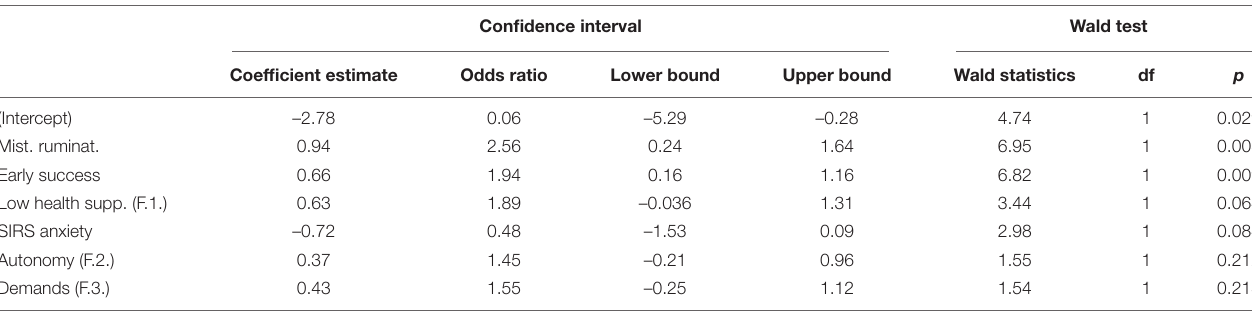
TABLE 9 | Musicians’ focal dystonia (MFD) risk factor coefficients from logistic